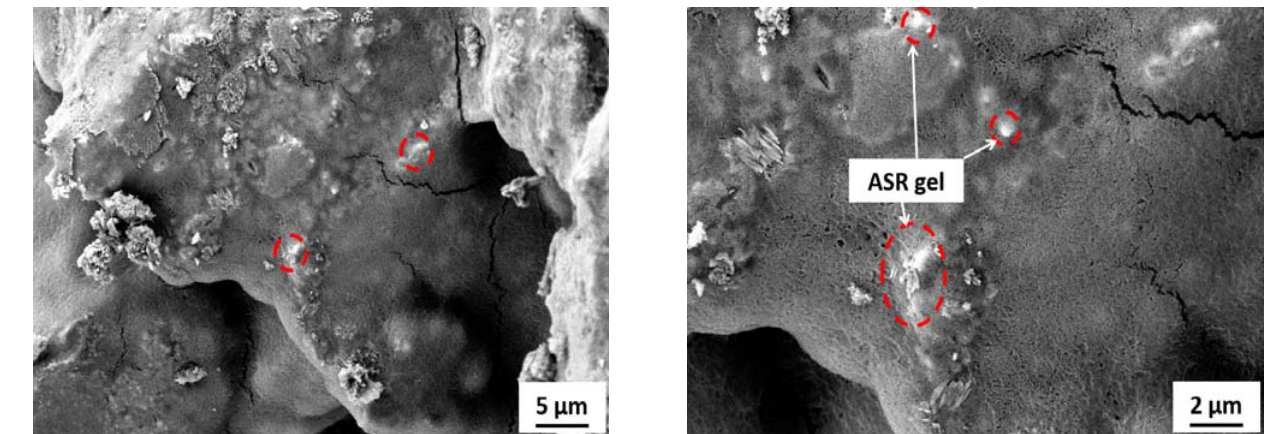
Figure 17. Formation of ASR gel in specimens exposed to ASR environment. (ASR gel location is shown by red dashed circles).